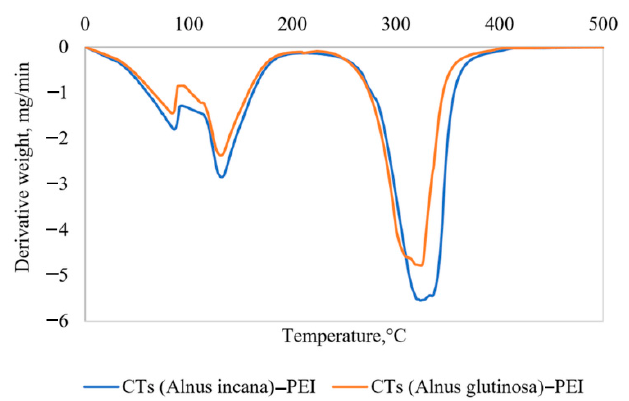
Figure 8. Differential thermogravimetric curves of Alnus incana and Alnus glutinosa bark CTs–PEI adhesive system.